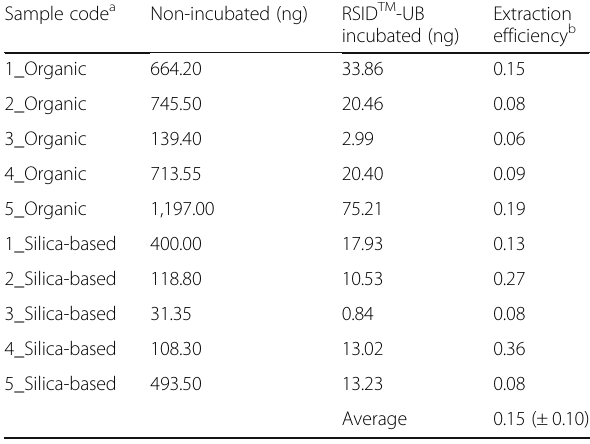
Table 3 Extraction efficiency of RSID TM -Universal Buffer based on DNA quantitation Sample code